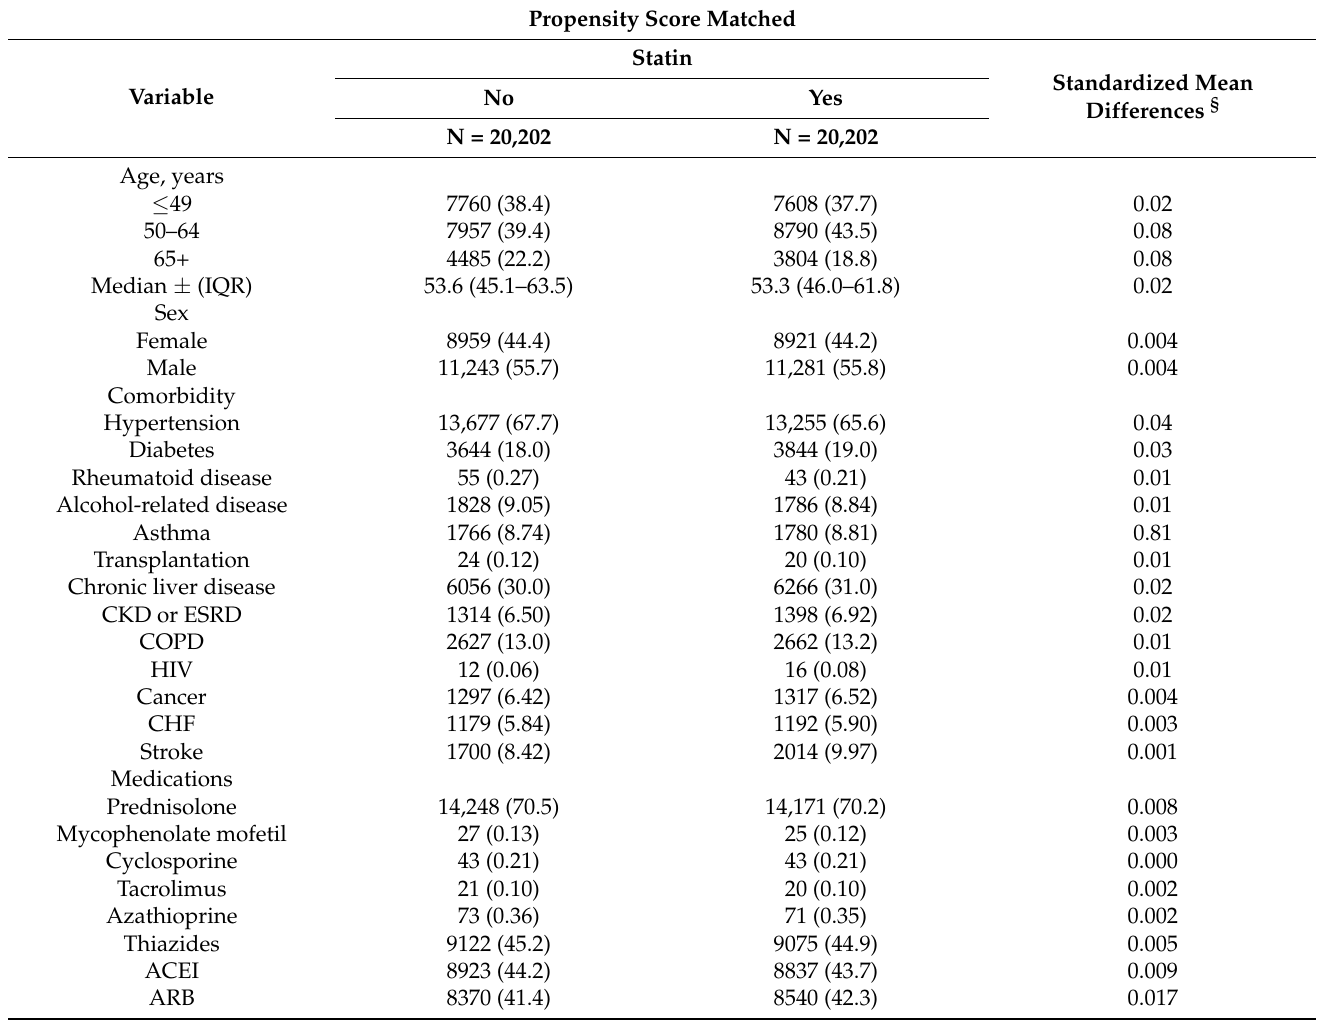
Table 1. Demographic characteristics and comorbidities compared between statin users and propensity-score-matched